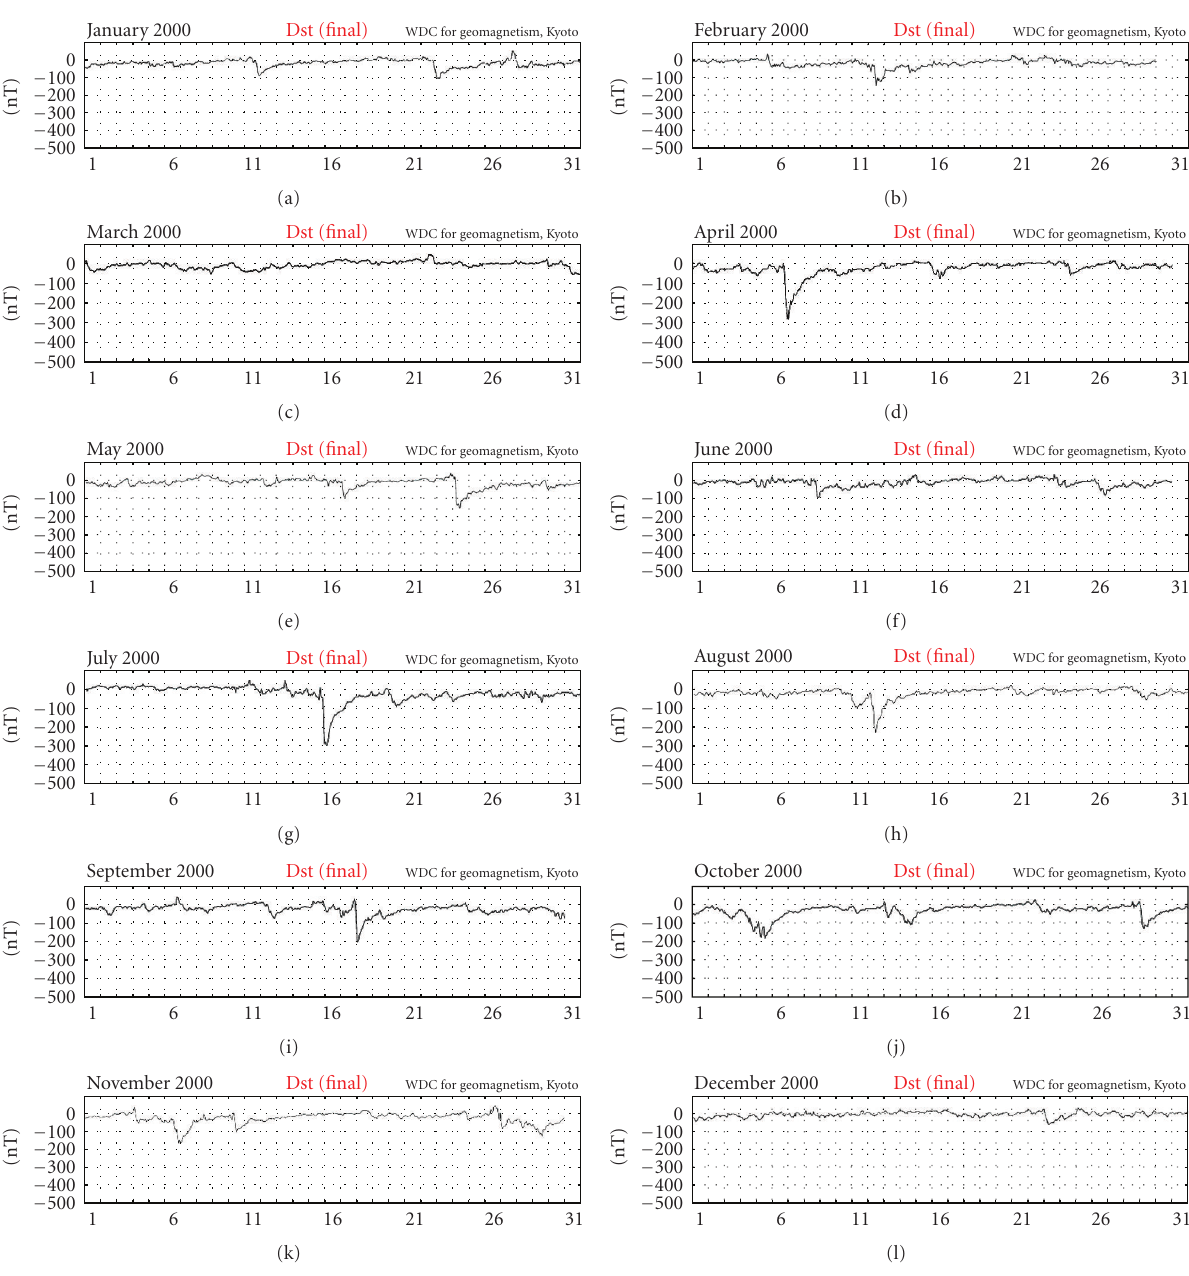
Figure 7: This figure denotes the Dst indices for year 2000 in